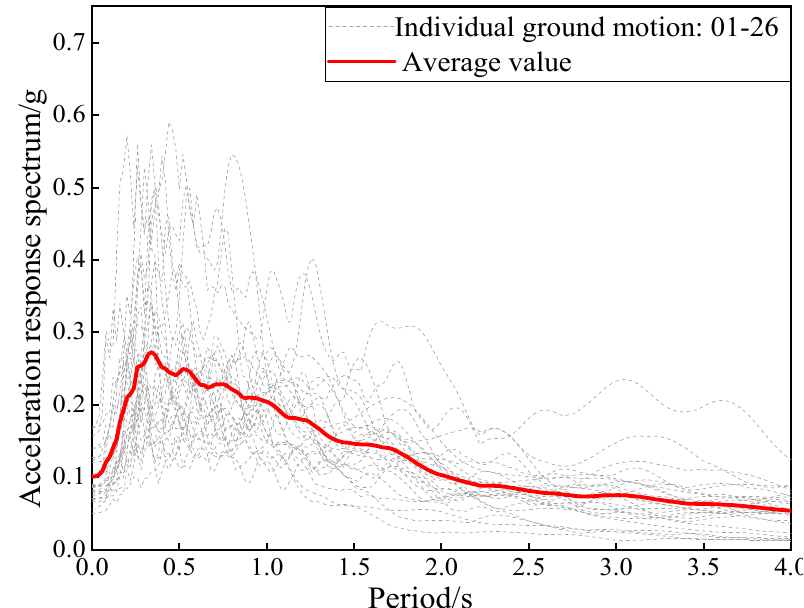
Figure 4. Mainshock response spectrum curves.